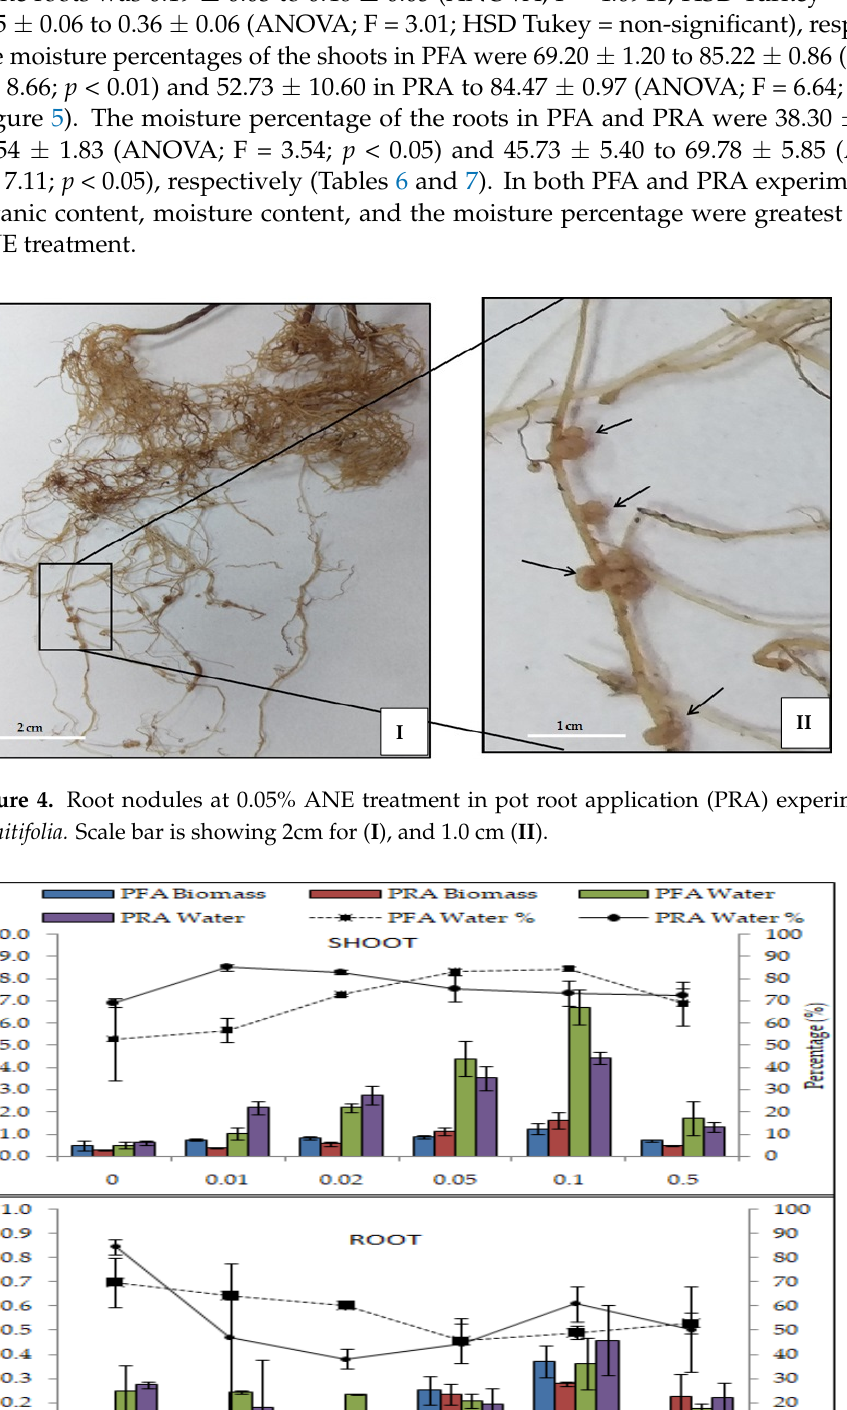
Table 6. ANOVA for the efficacy of ANE via PFA and PRA experiments on biomass accumulation in shoots.